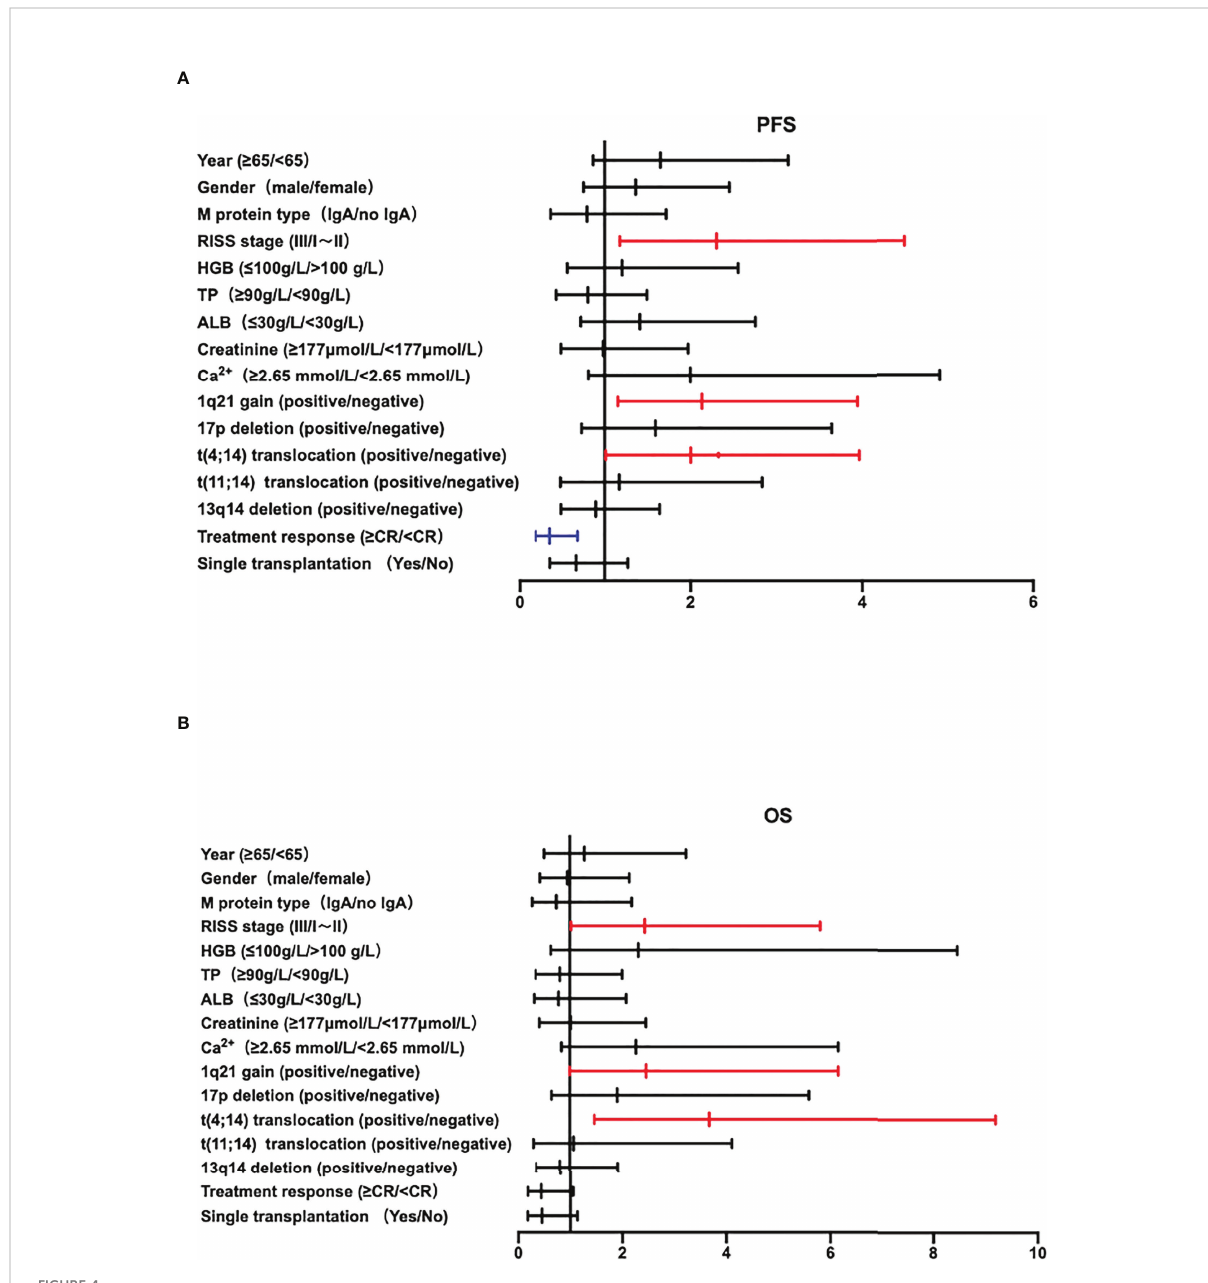
FIGURE 4 (A, B) The Forest plot of PFS and OS of multivariate analysis of prognostic factors in NDMM